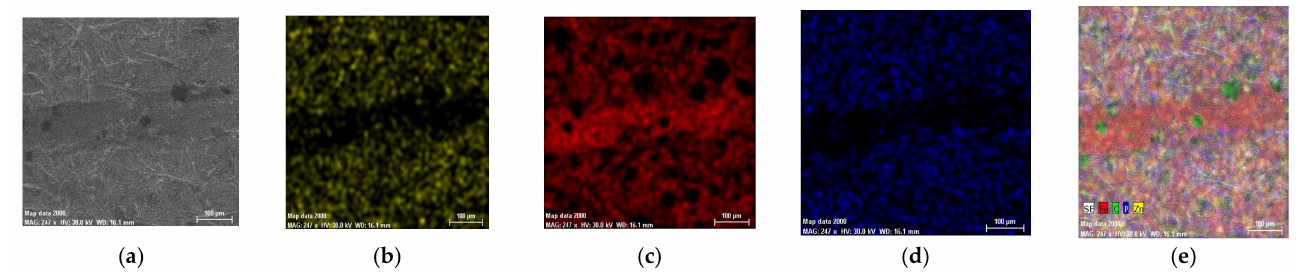
Figure 17. EDX images for the scratch test on the phosphate nodular cast iron sample: ( a ) general view; ( b ) Zn distribution; ( c ) Fe distribution; ( d ) distribution P; ( e ) all